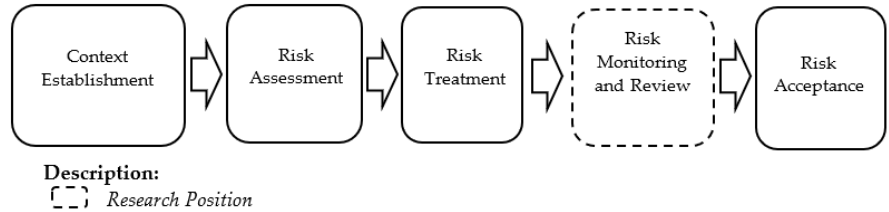
Figure 3. Research Position within the ISO 27005 Framework.